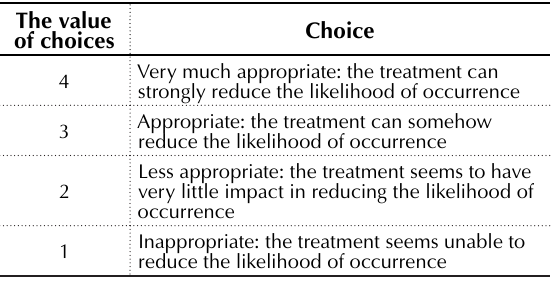
Table 2. The appropriateness of risk